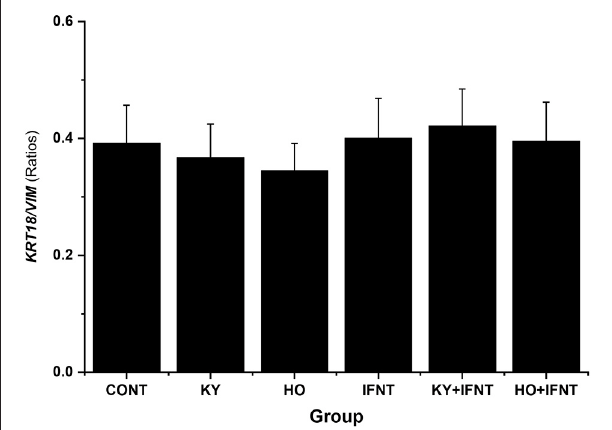
FIGURE 1 | Effect of two ncpBVDV-1 strains, IFNT and their combination on the ratio of epithelial to stromal cells present in the cultures. Primary cultures of mixed bovine endometrial cells (epithelium plus stroma) were cultured for 4 days before inoculation with either KY1203 (KY) or Ho916 (HO) strains of ncpBVDV-1. After a further 4 days, half the cultures were then stimulated with 100 ng/mlL IFNT and the cultures were terminated 24h later. CONT, untreated control cultures. All treatments were replicated using cells from 10 cows. Values are mean ± SEM. There was no difference in ratio due to treatment (ANOVA, P > 0.05). Gene expression of KRT18 and VIM was used as markers of epithelial and stromal cells, respectively.